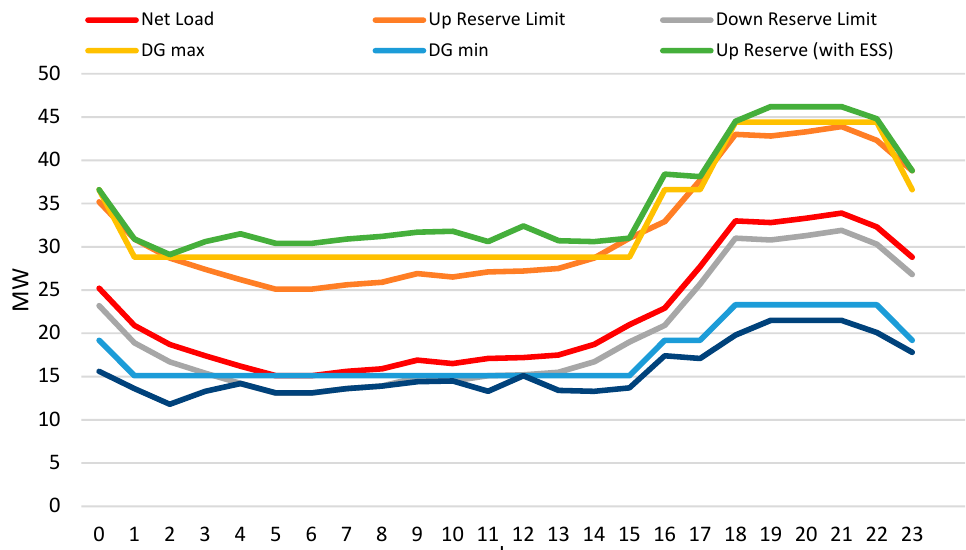
Figure 6. The up- and down-spinning reserve for the day with minimum load (case 1). The up-spinning reserve was at the minimum up reserve at the 1st, 15th, 17th, and 23rd hours because of the transition of the system when a diesel generator turned off or on. With this transition, the PSS operated to maintain the up-spinning reserve limit. At the 1st and 2nd hour, the PSS-available power was added to the operating reserve allowing the shutdown of one unit. During the 15th and 17th hours, because of the increase in load, from Figure 4) for support and maintaining the up reserve limit. This was also seen at the operating reserve at its